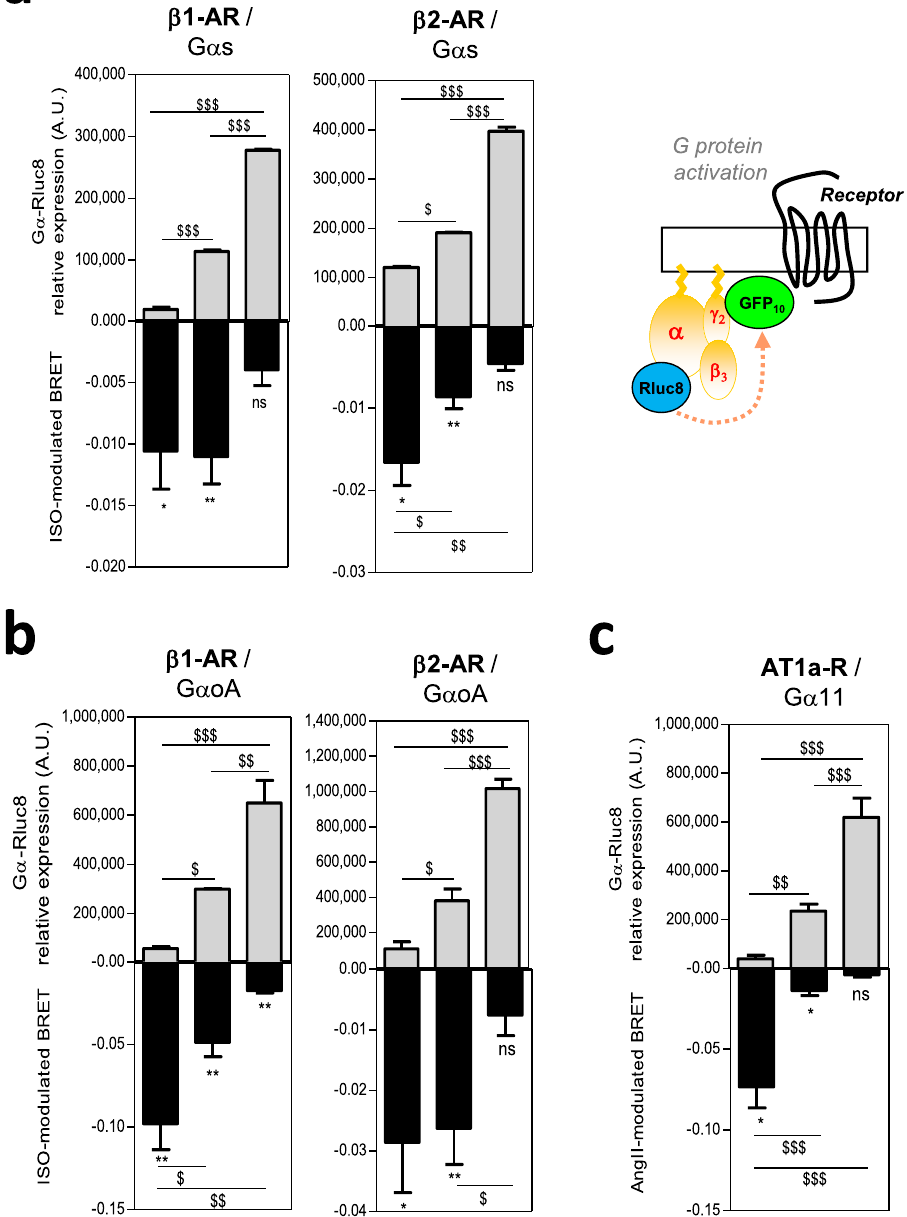
Figure 2. G α subunit expression level impacts on agonist-mediated G protein activation. ( a,b ) BRET (black) in HEK293T cells co-expressing HA- β 1-AR (left panels) or HA- β 2-AR (right panels) or ( c ) AT1a-R receptors and different expression levels of G α s-Rluc8 ( a ) or G α oA-Rluc8 ( b ) or G α 11-Rluc8 ( c ) in the presence of fixed GFP10-G γ 2 and G β 3 untagged subunits. Cells were stimulated or not for 1 min with 10 µ M of the indicated selective agonists isoproterenol (ISO) or angiotensin II (AngII). Results are expressed as the difference in BRET signals measured in presence and absence of ligand. Data represent the mean ± s.e.m. of at least three independent experiments. The statistical significance between stimulated and unstimulated cells was assessed using paired Student’s t-test ( * P < 0.05, ** P < 0.01, *** P < 0.001). G α -Rluc8 relative expression levels (gray) were depicted by the luminescence measurement and represent the mean ± s.e.m. of at least three independent experiments. The statistical significance of the difference in luminescence between G α expression levels was assessed using one-way ANOVA followed by a Tukey’s multiple comparison test ( $ P < 0.05, $$ P < 0.01, $$$ P <